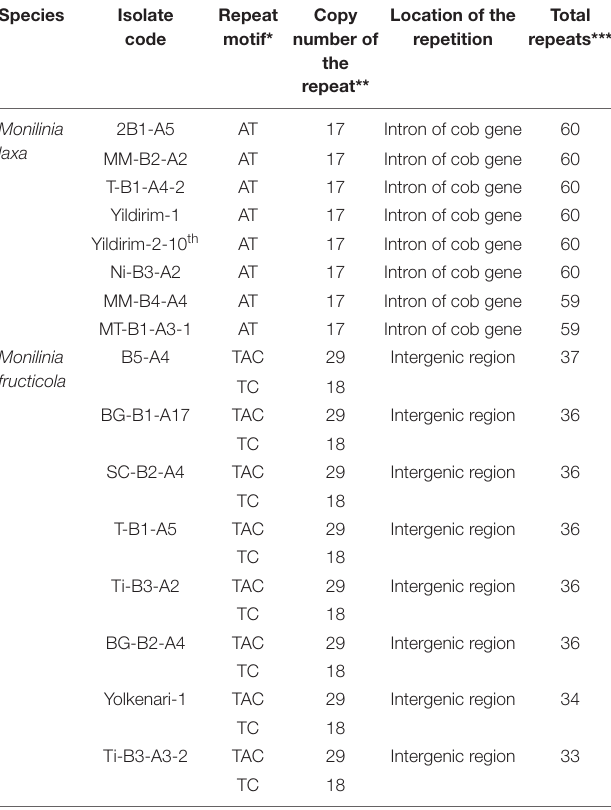
TABLE 3 | Information on repetitive motifs detected in the mitogenomes of 16 isolates of number Monilinia spp. Species Isolate